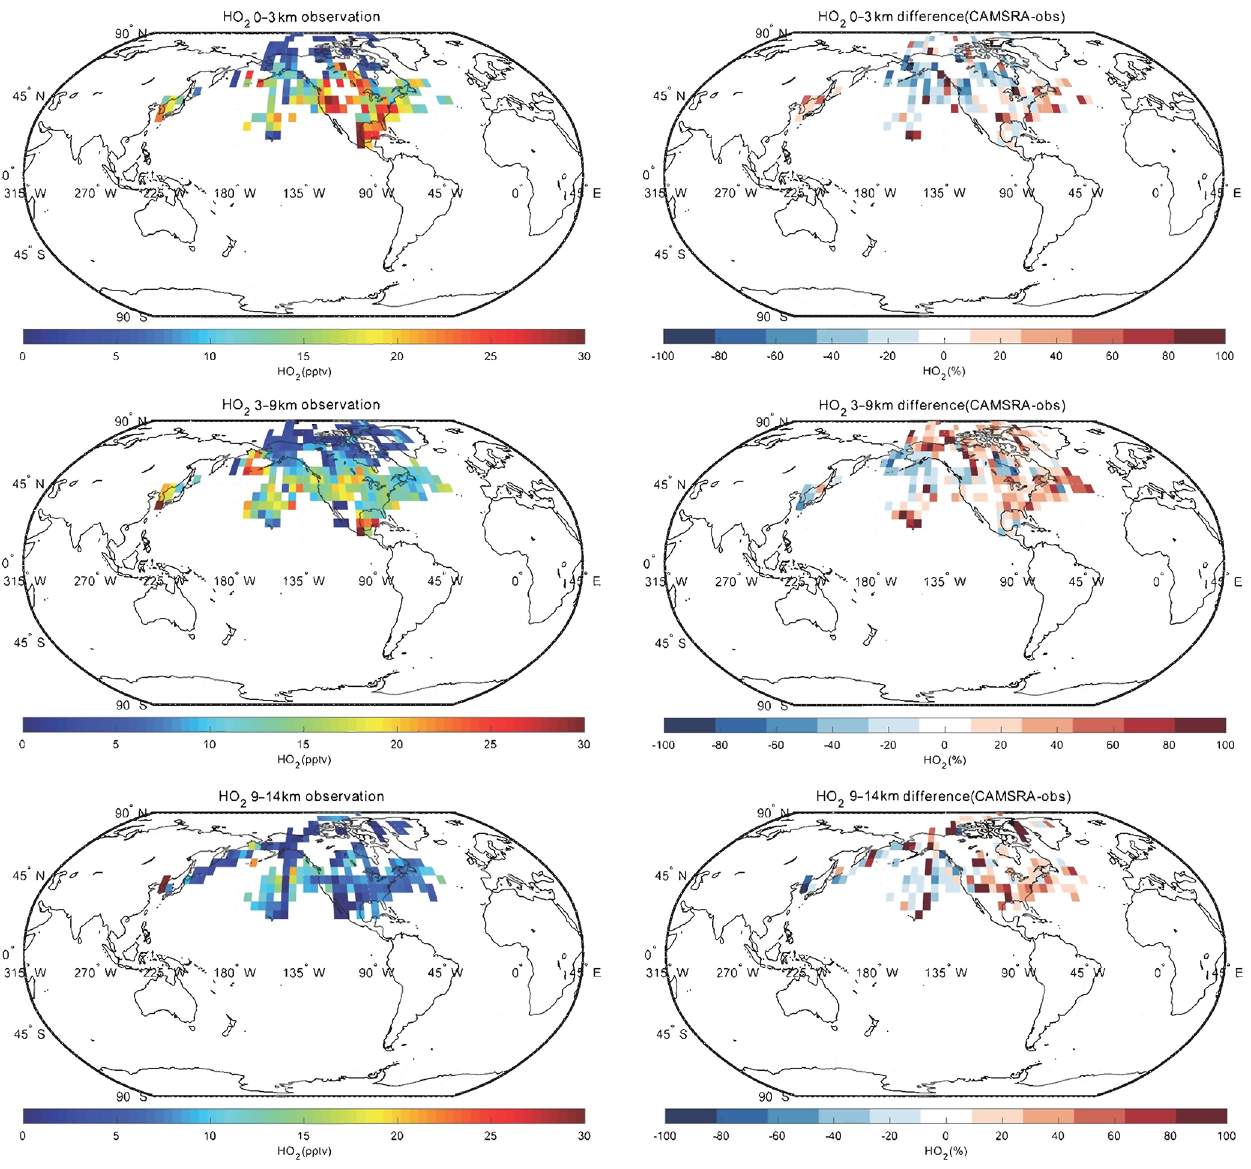
Figure A4. Same as Fig. A1, but for HO 2